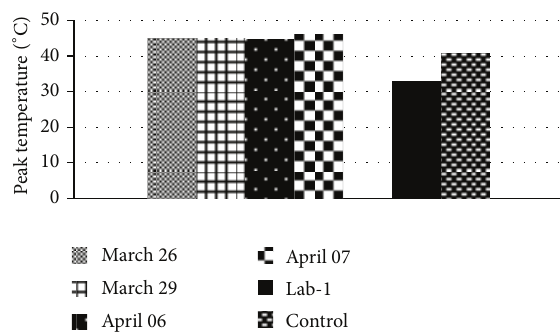
Figure 5: Out-wind peak temperatures for the four hottest days of the study period. “Lab-1” and “control” are the averages of the peak temperatures recorded in Lab-1 and control ward, respectively, during these 4